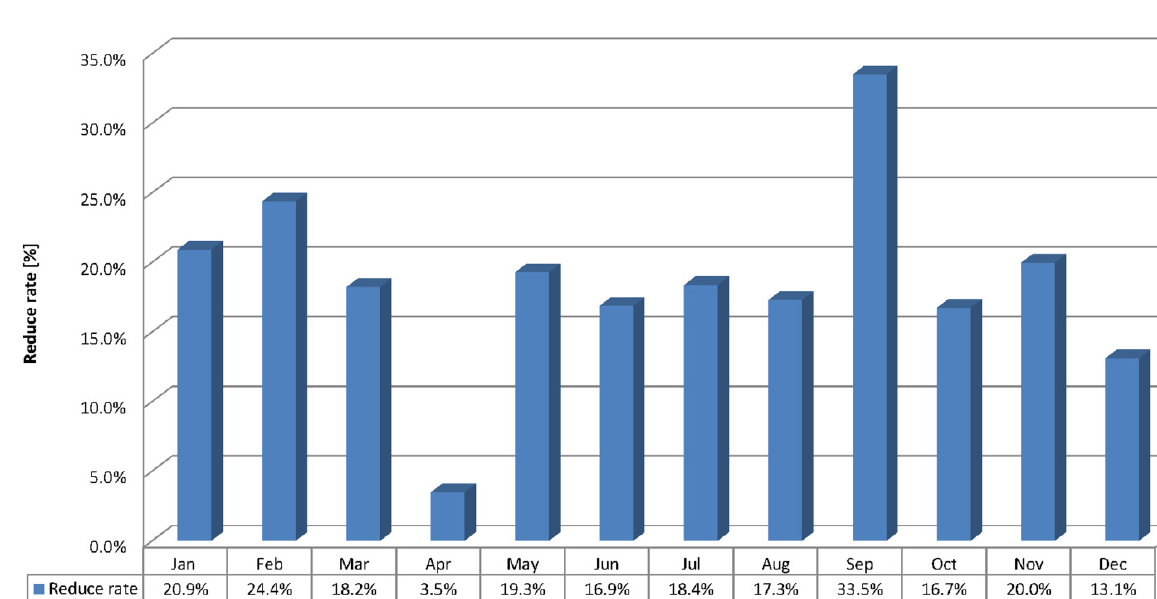
Figure 8. Reduction rate of energy intensity for 2011 to